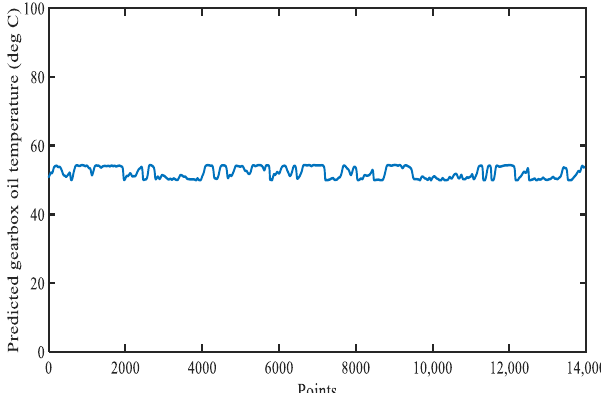
Figure 11. Predicted temperature of the gearbox oil gained from the LSTM model.